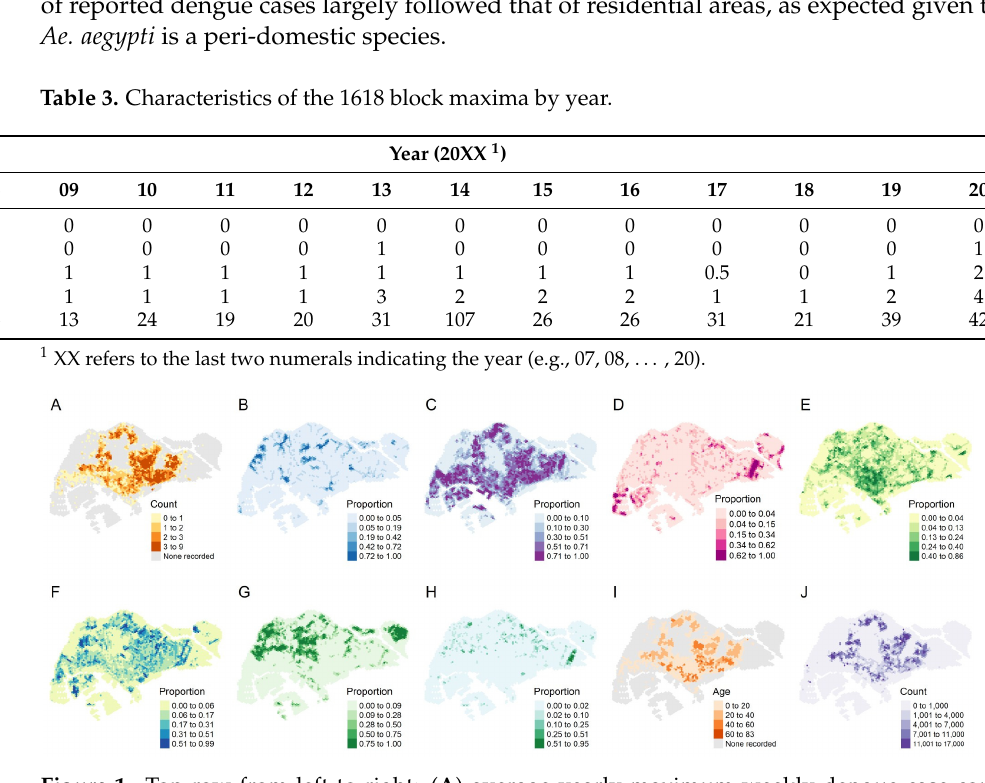
Figure 1. Top row from left to right: ( A ) average yearly maximum weekly dengue case counts from 2007 to 2020, ( B ) proportion of freshwater surfaces, ( C ) proportion of impervious surfaces, ( D ) proportion of non-vegetated pervious surfaces, and ( E ) proportion of vegetation with structure dominated by human management with tree canopy. Bottom row from left to right: ( F ) proportion of vegetation with structure dominated by human management without tree canopy, ( G ) proportion of vegetation with limited human management with tree canopy, ( H ) proportion of vegetation with limited human management with tree canopy, ( I ) median age of public apartments, and ( J ) population size in